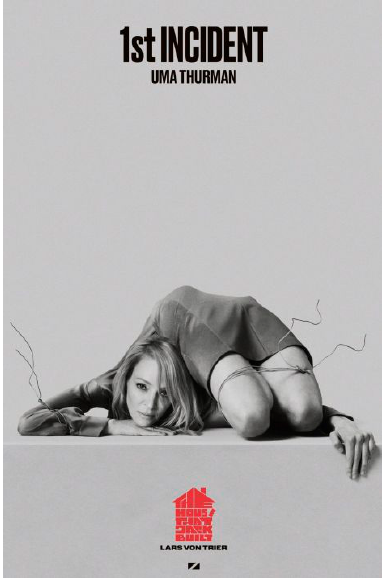
Figure 4. The Einstein Couple, a poster for Lars von Trier’s The House that Jack Built , 2018, (featuring Uma Thurman). Courtesy of Zentropa and The Einstein Couple.